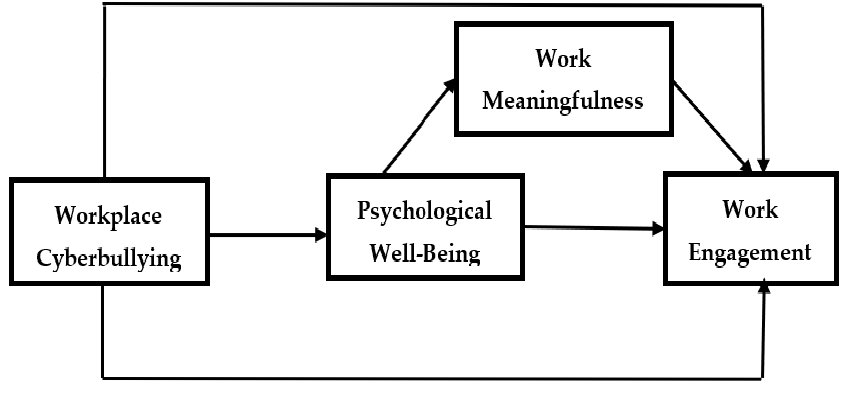
Figure 1. Theoretical